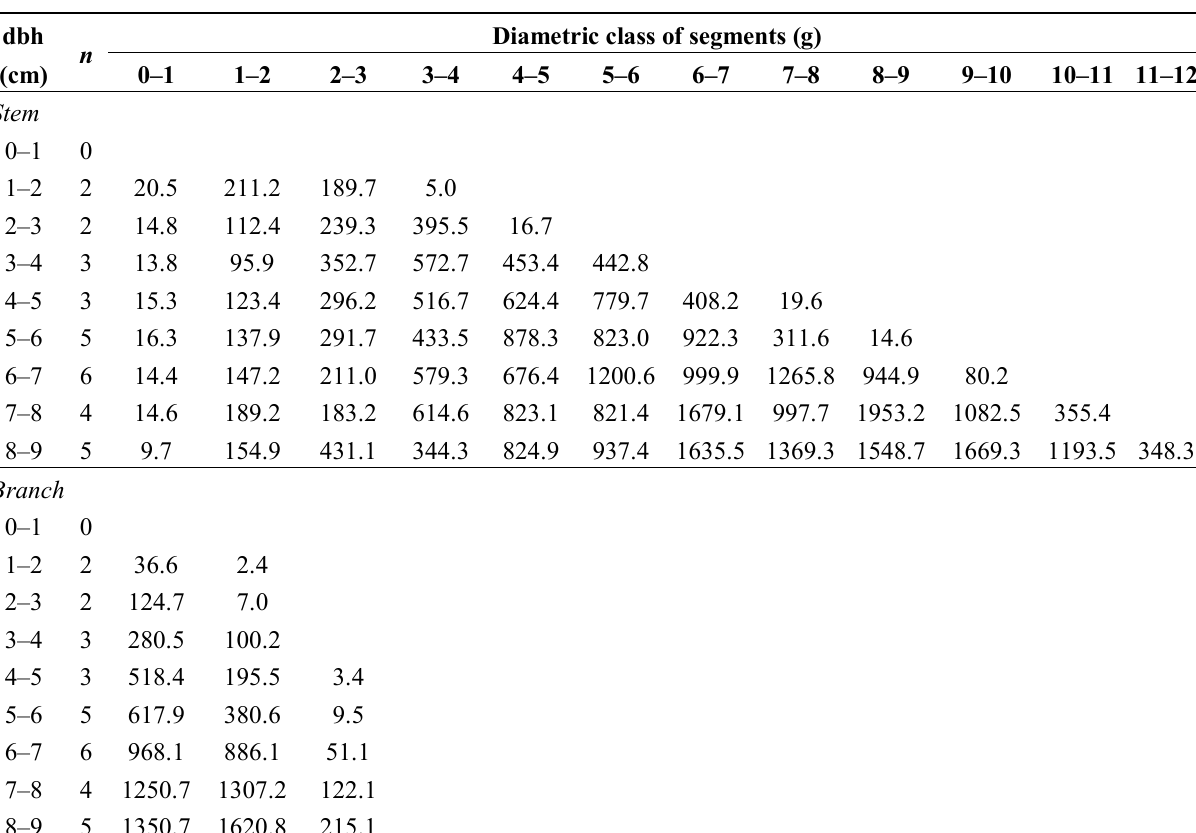
Table 4. Calculated dry weights for stem and branch sections by diameter